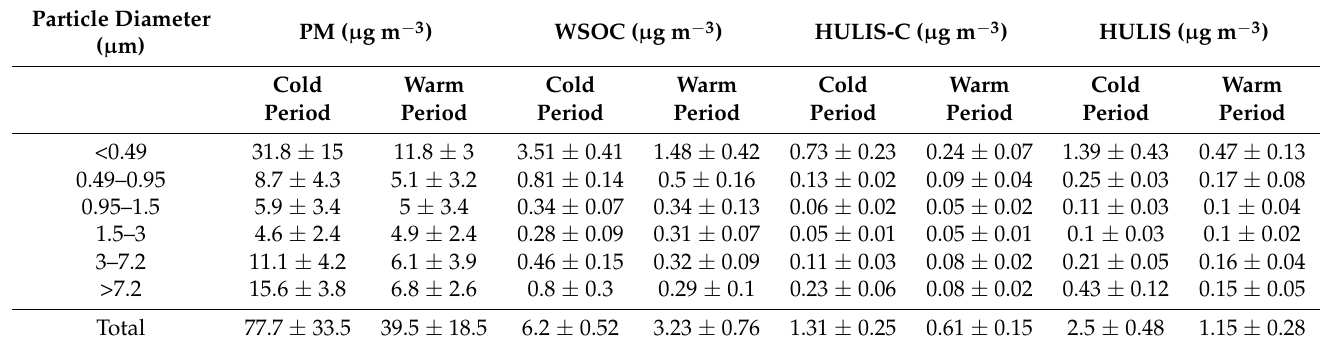
Table 1. Mean (± standard deviation) size-resolved concentrations of PM mass, WSOC, HULIS-C and HULIS in the cold and warm sampling periods.